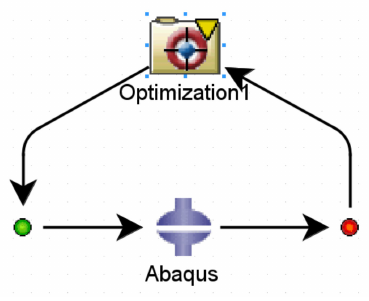
Figure 10. Optimization sim-flow.